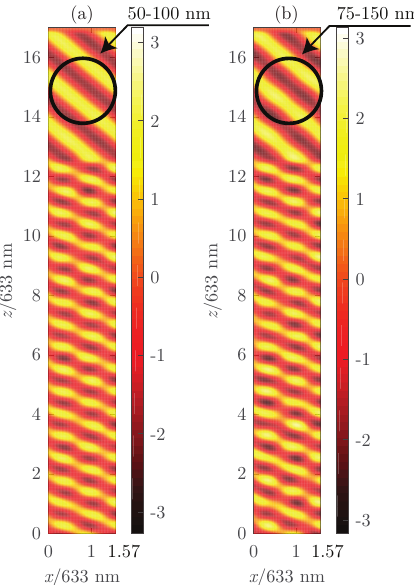
Figure 10. Field distribution of the E y component as a function of space for θ inc = 50 ◦ and S = 0.74: ( a ) size of the droplets between 50 and 100 nm; ( b ) size of the droplets between 75 and 150 nm.